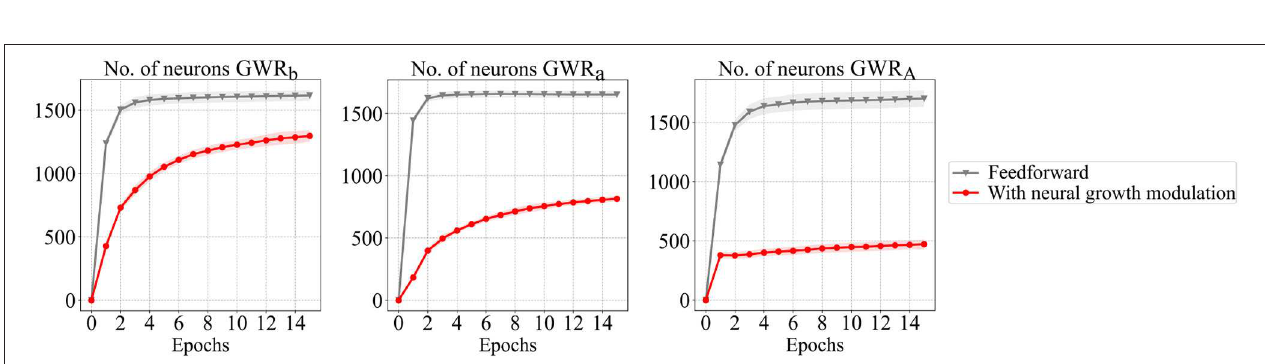
FIGURE 7 | The number of neurons over the training epochs for the GWR networks with and without the top-down neural growth modulation (Mici, 2018). The results are averaged over 4-fold cross-validation